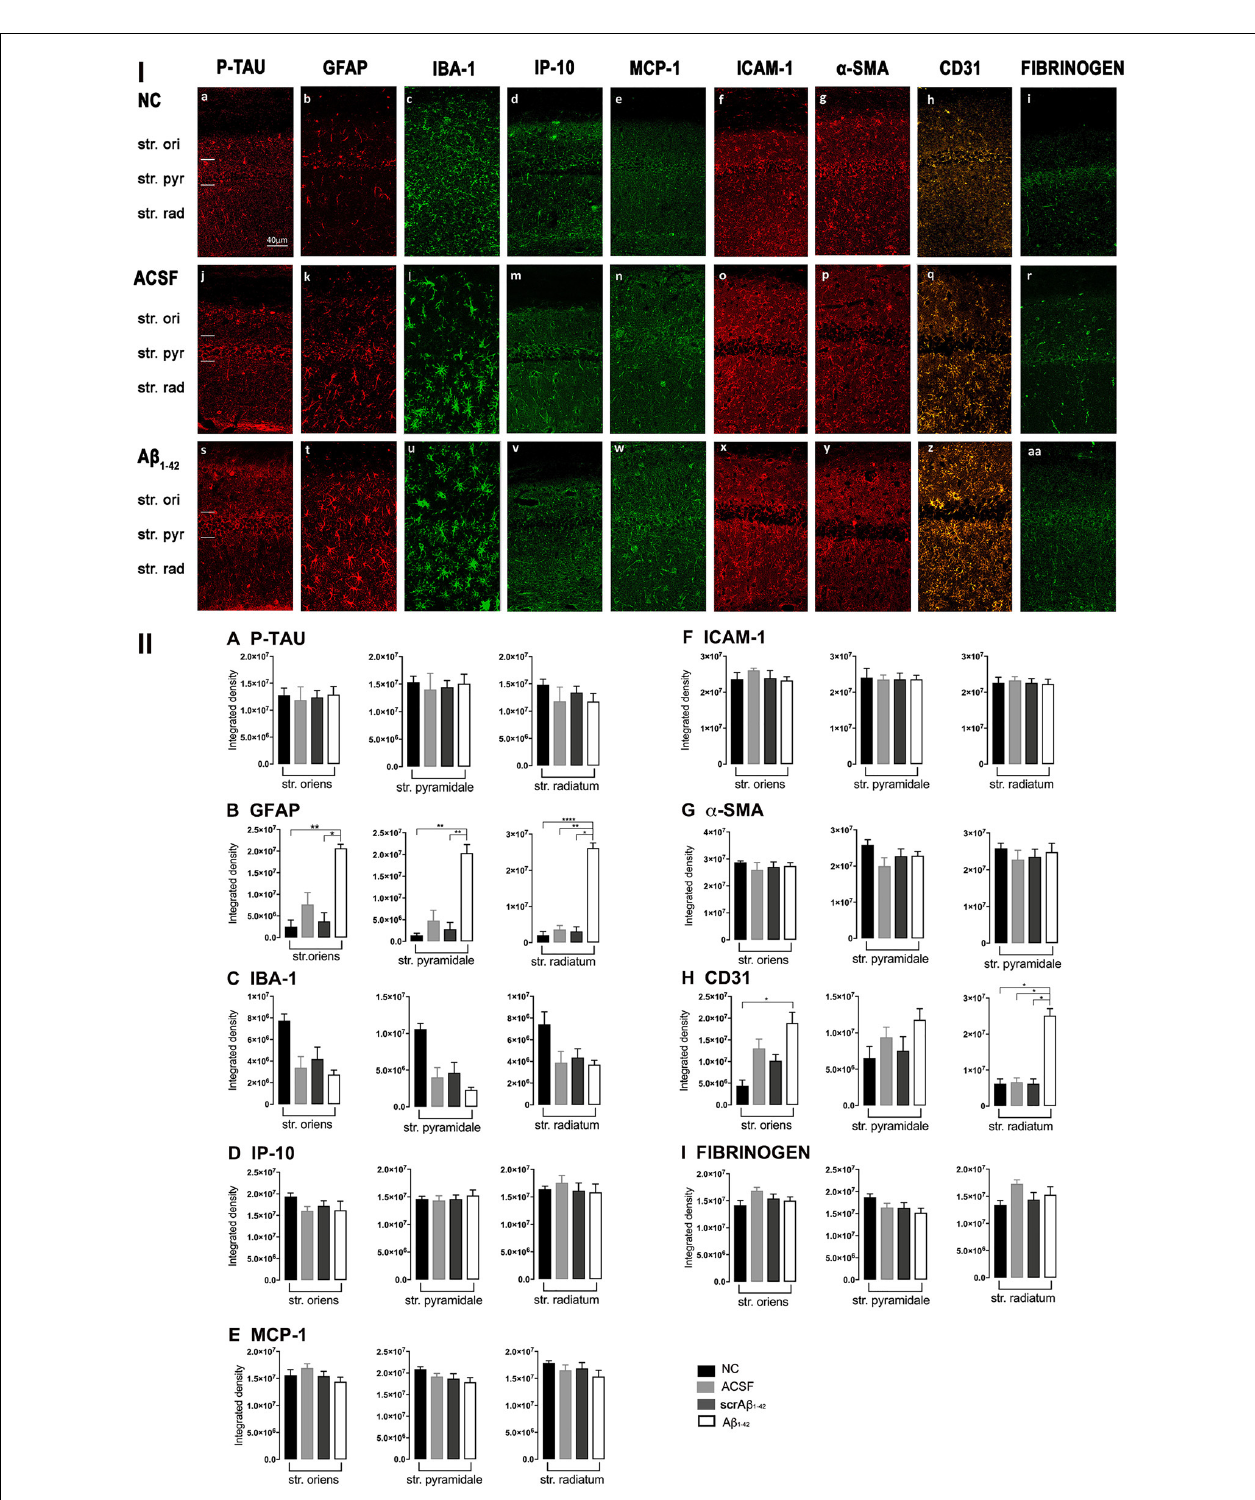
FIGURE 3 | Panel I: Representative images showing immunolabeling of p-tau, GFAP, Iba-1, IP-10, MCP-1, ICAM-1, α -SMA, CD31, and fibrinogen at a location adjacent to the injection site, 3 days after injection in NC (a–i) , ACSF- (j–r) and A β 1–42 -injected (s–aa) mice. Scale bar (40 µ m). Panel II: Graphs showing quantification at a location adjacent to the injection site in the CA1 hippocampal region of p-tau, GFAP, Iba-1, IP-10, MCP-1, ICAM-1, α -SMA, CD31, and fibrinogen (A–I) immunolabeling density, 3 days post-injection in NC, ACSF-, scrA β 1–42 - and A β 1–42 -injected mice. Data expressed as mean ± SEM (Kruskal–Wallis test; * p < 0.05; ** p < 0.01, **** p < 0.0001, n = 6).